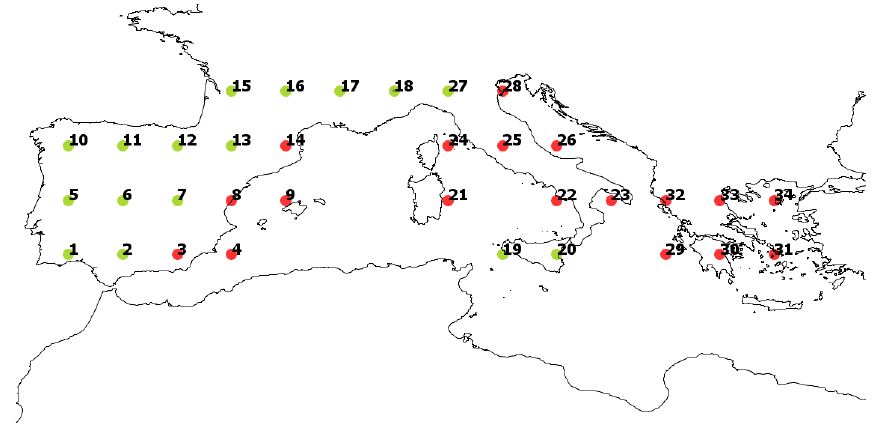
Figure 1. Identification of the National Center for Environmental Prediction (NCEP) reanalysis analyzed points in the study area (Portugal, Spain, the south of France, Italy, and Greece). Red points mean a significant increase ( p value < 0.05) in the annual number of days with an air temperature higher than 20 ◦ C at 850hPa (HTD 20 ) in the June–September period from 1978 to 2012. Green points mean that there were no significant changes in terms of annual number of HTD 20 .